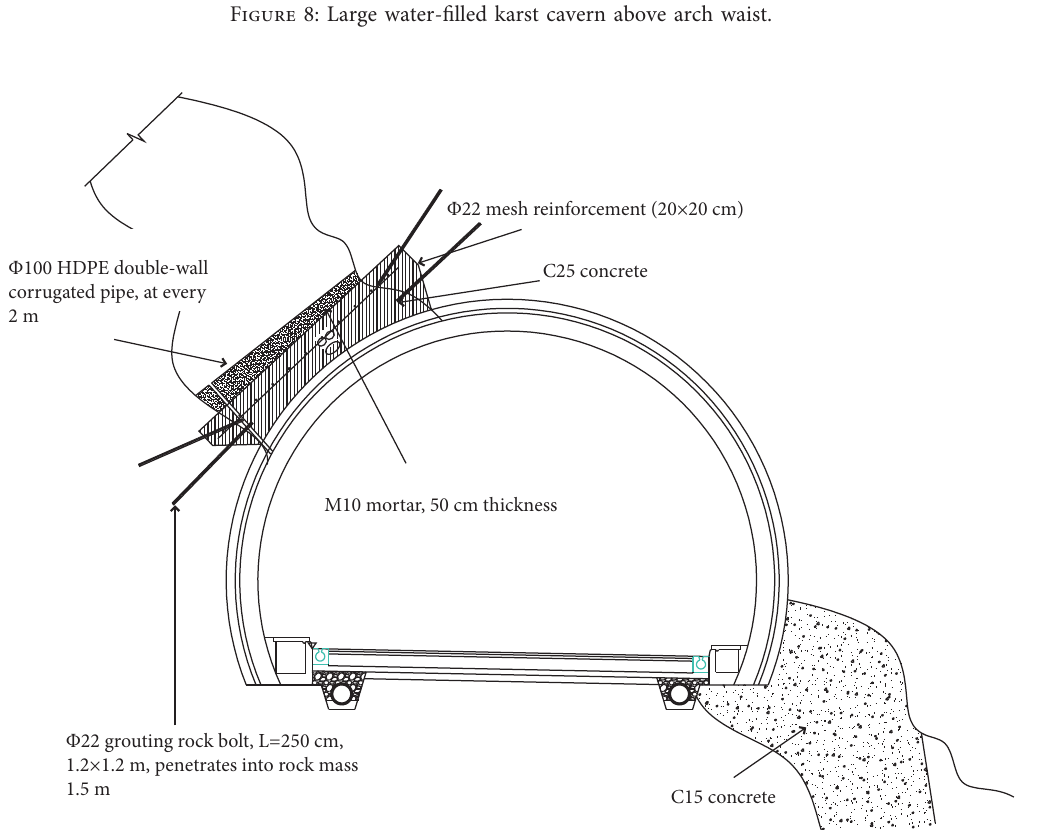
Figure 9: Large, empty karst cavern above arch